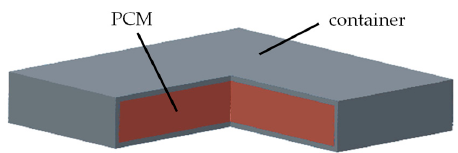
Figure 2. The 3D diagram and cross section of the testing specimen.